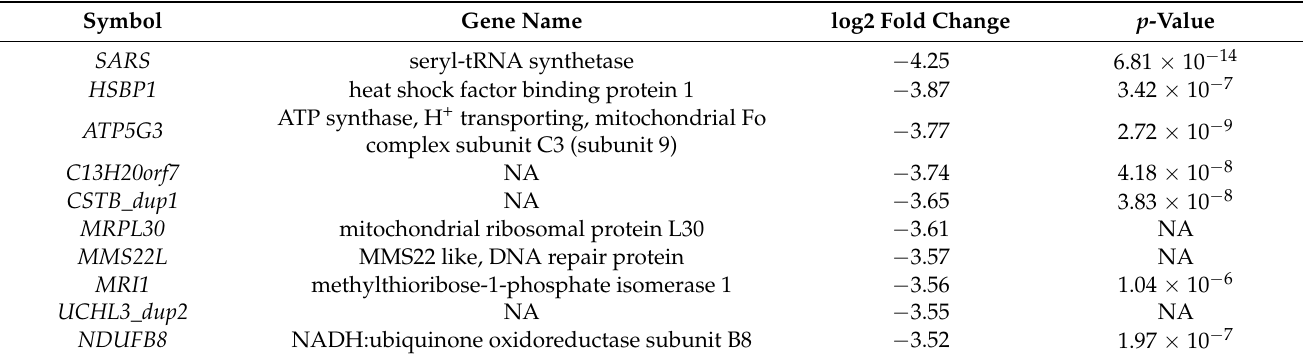
Table 1. Top 10 genes expressed in embryos developing into